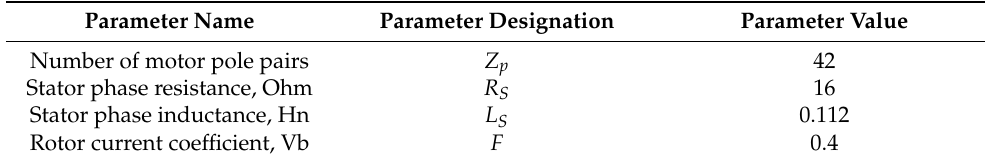
Table 1. Motor parameters.